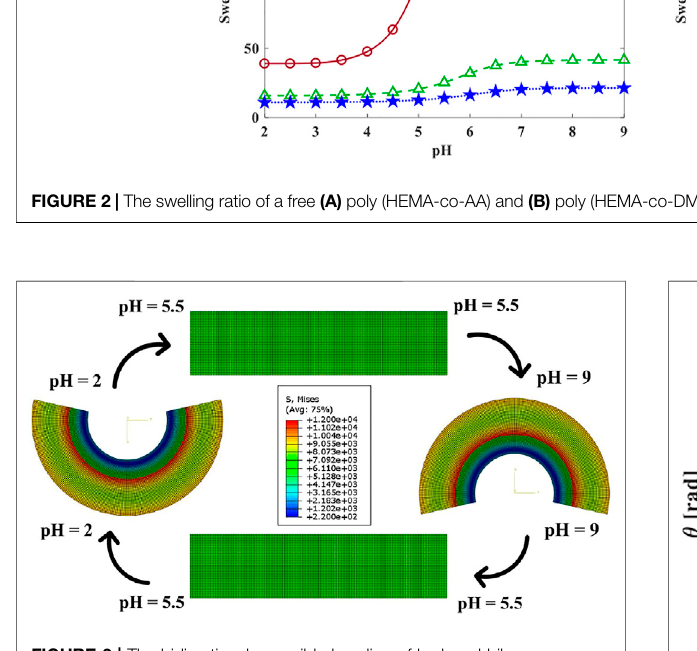
FIGURE 3 | The bidirectional reversible bending of hydrogel bilayer composed of poly (HEMA-co-AA) and poly (HEMA-co-DMAEMA) under pH variation described in Equation 27 .